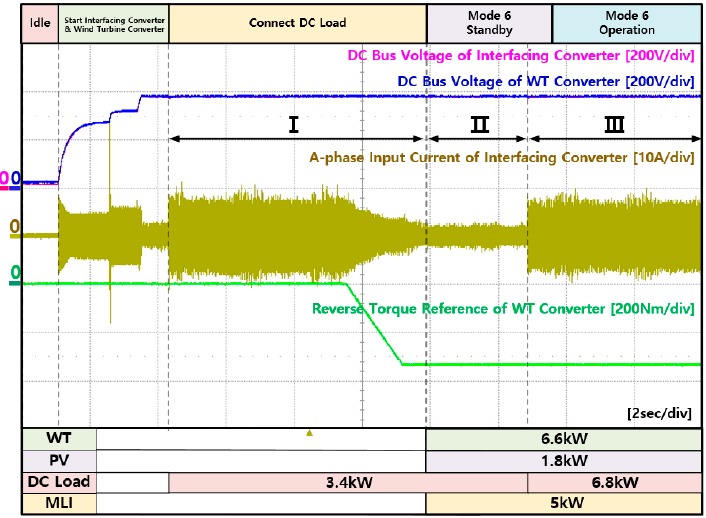
Figure 30. Experiment waveforms of interfacing converter and WT converter in mode 6.